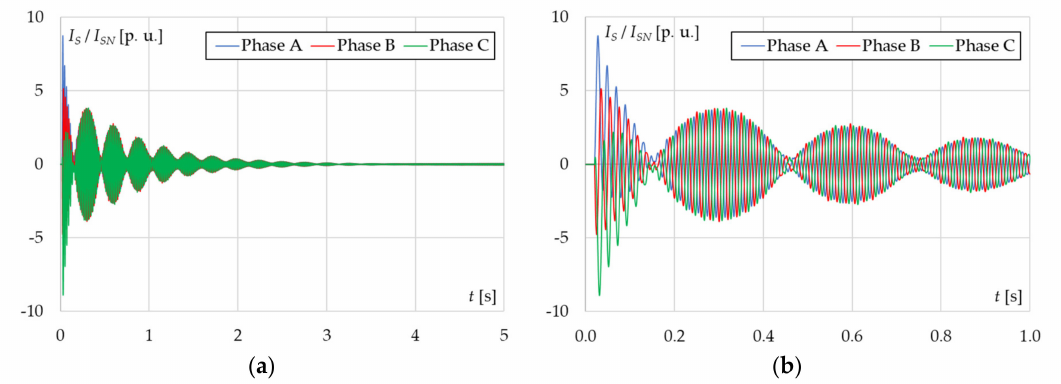
Figure 14. Waveforms of stator current during out-of-phase synchronization of − 120 ◦ in ( a ) the scope of the considered calculation time and ( b ) the first